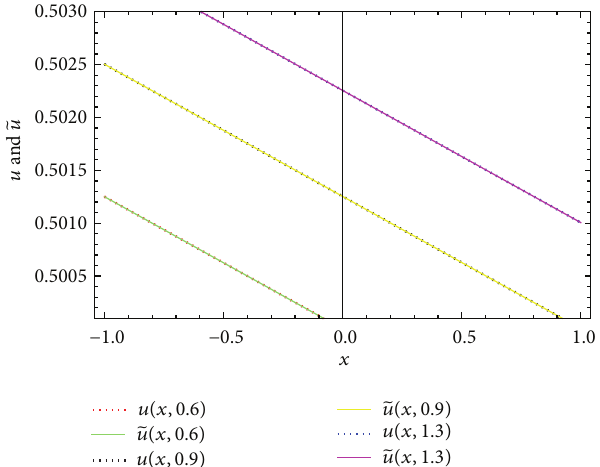
Figure 11: The approximate and exact solutions for different values of 𝑡 (0, 0.5 and 0.9) of problem (44) where 𝛼 = 𝛽 = 0 and ] = 𝛾 = 10 −2 at 𝑁 = 20 .